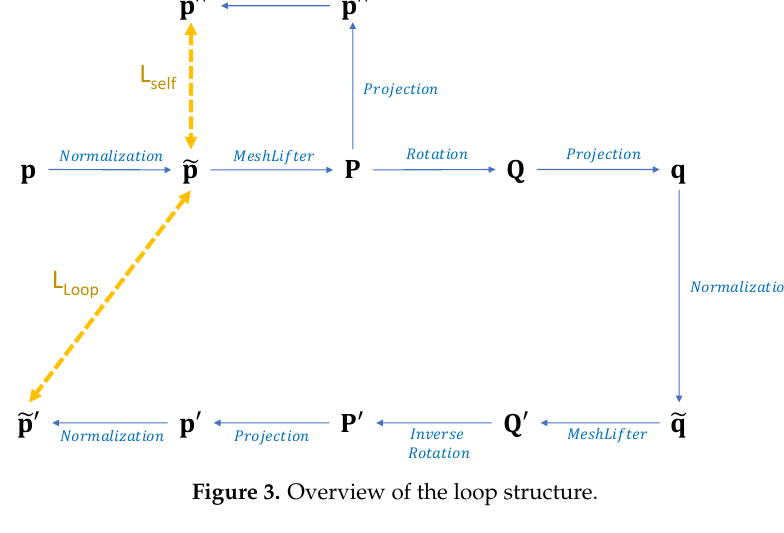
Figure 3. Overview of the loop structure.